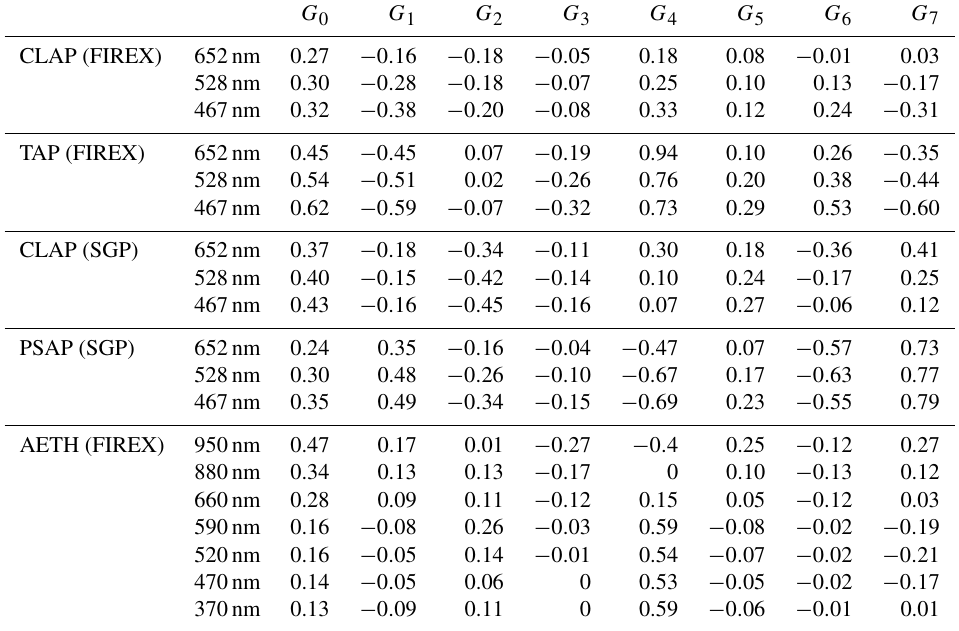
Table 4. Coefficient values for Eq. (9) derived using Algorithm A. We recommend these as the initial guesses when implementing Algorithm B ∗